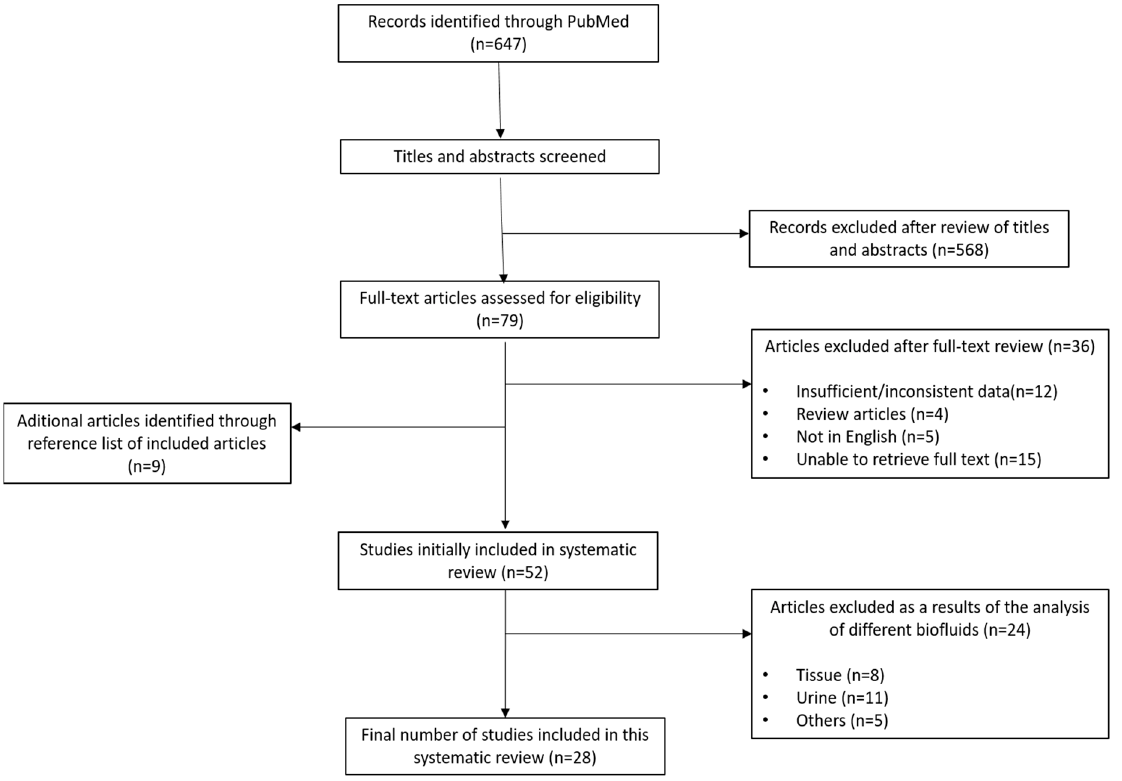
Figure 1. Flowchart of the literature search process and selection of studies. Table 1. Risk of bias for the included studies, using the modified Newcastle-Ottawa Quality As- sessment Scale adapted for cross-sectional studies [9].